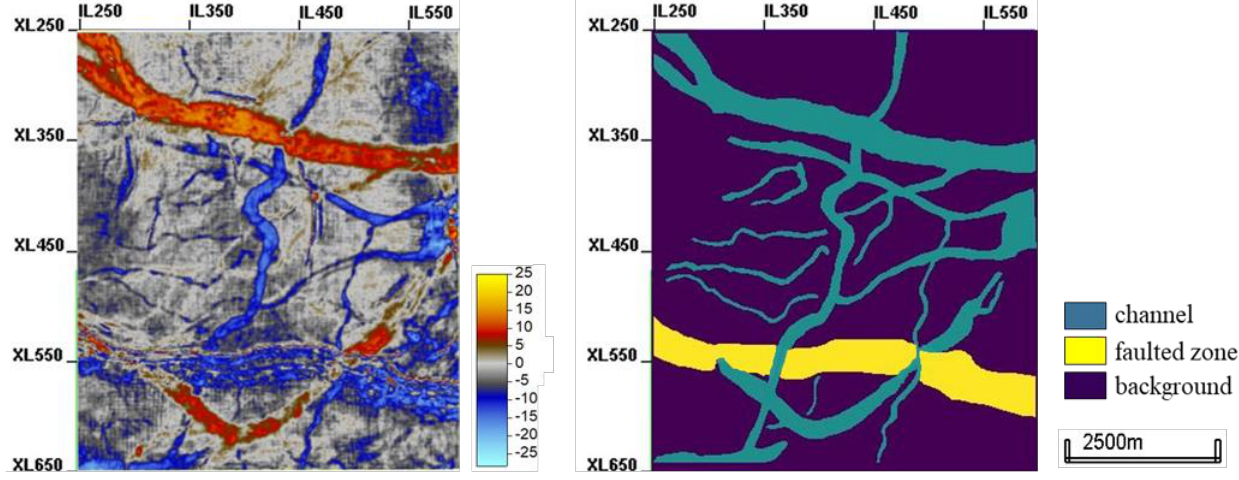
Figure 6. Stratigraphic seismic slice extracted at the time −1 034 ms ( a ) and the corresponding label ( b ). Interpretation was done by interpreters at RIPED. Though there is uncertainty associated with labels, especially where the faulted zone and channels overlap, the goal of this work was to test the supervised algorithm, so human interpretation uncertainty was not taken into account.